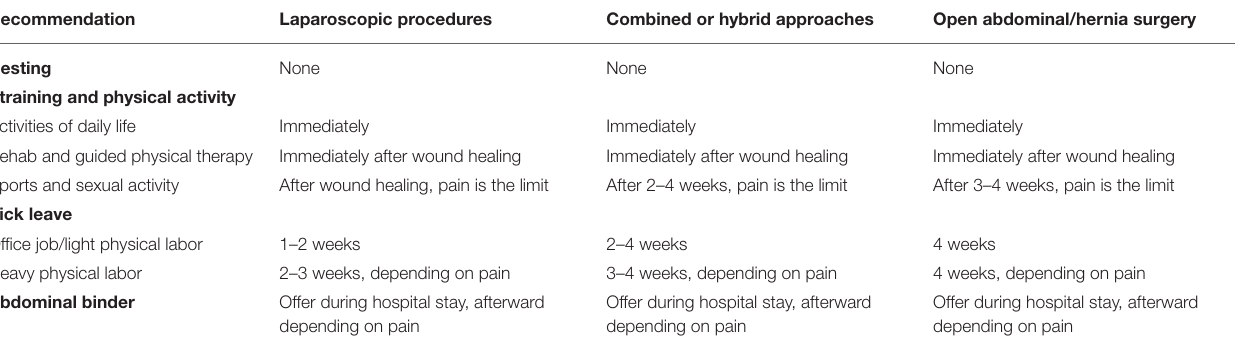
TABLE 1 | Recommendations of postoperative activity after abdominal and hernia surgery were modified according to Güsgen et al. (2).